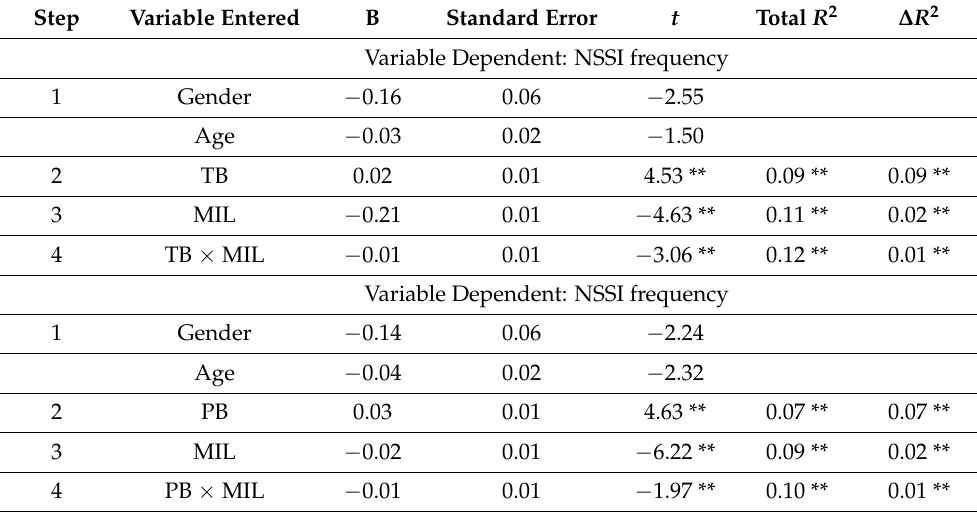
Table 2. Moderation effect of MIL in the association between thwarted belongingness, perceived burdensomeness, and NSSI